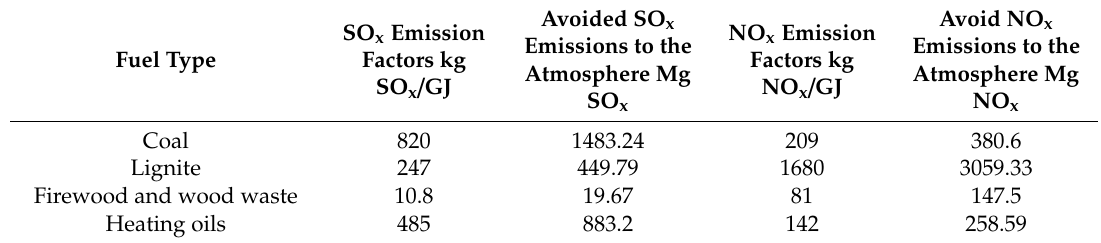
Table 8. Avoided SO x (Sulphur Oxides) and NO x (Nitrogen Oxides) emissions to the